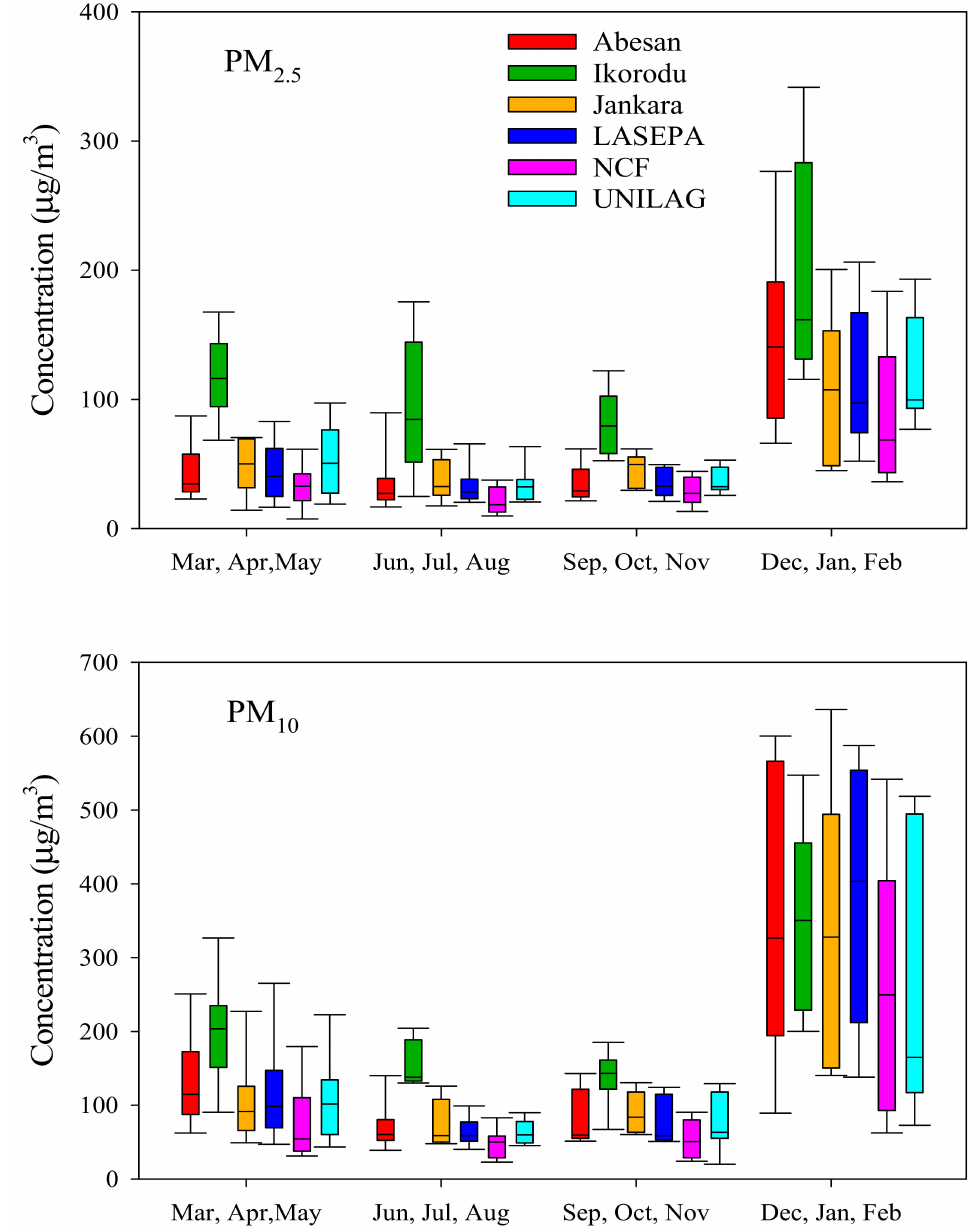
Figure 8. Seasonal variation in particle mass concentration for 24 h samples of fine ≤ 2.5 micrometer diameter (PM 2.5 ) and fine + coarse particles ≤ 10 micrometer diameter (PM 10